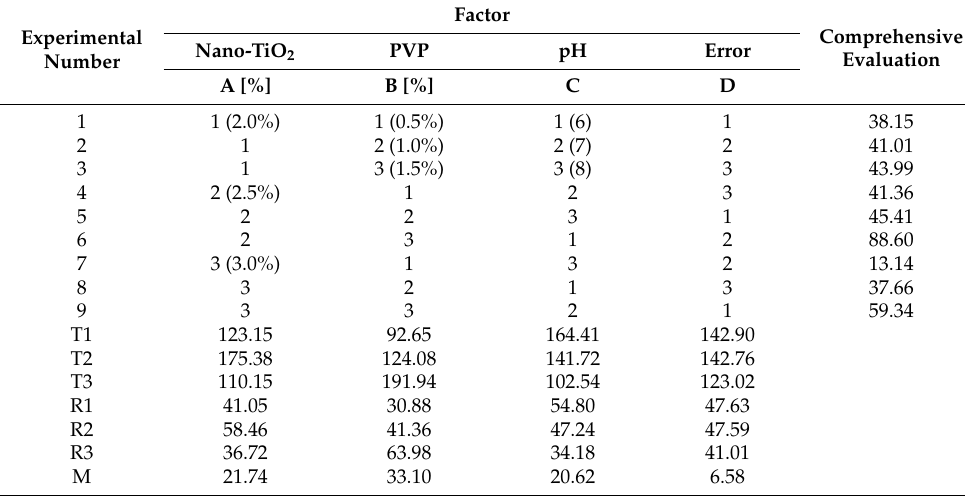
Table 2. Results and analysis of the filming orthogonal array design experiments.